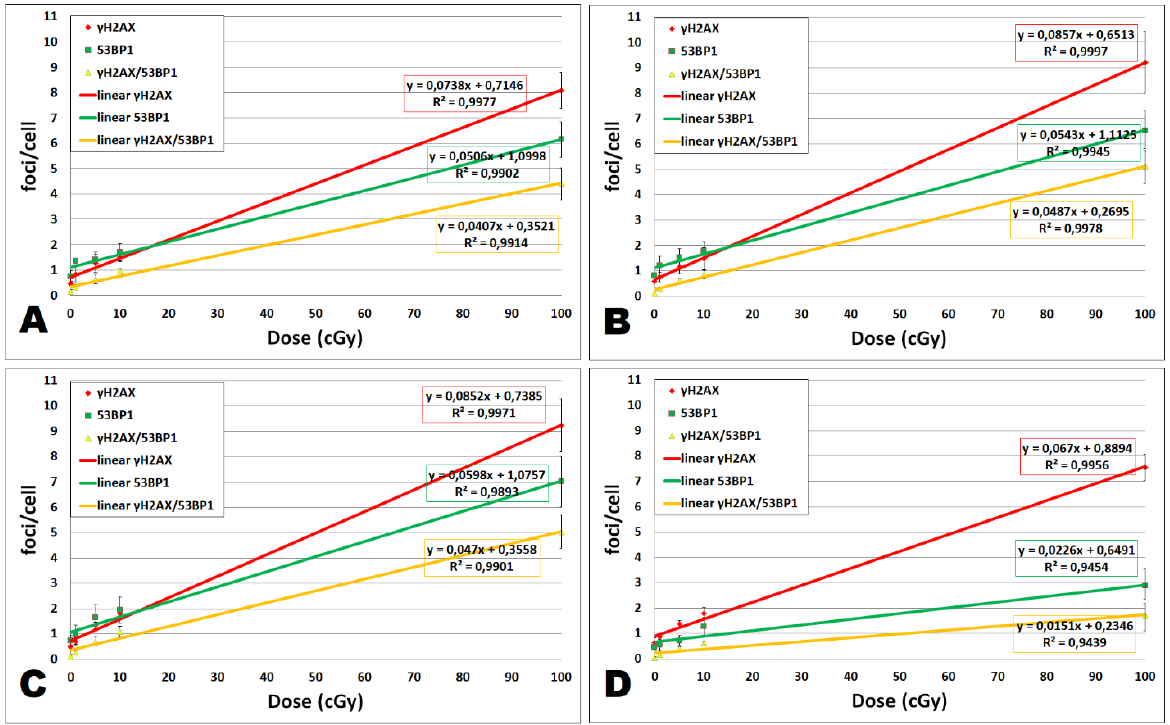
Figure 1. Linear fit for dose dependence of γ H2AX, 53BP1, and colocalized γ H2AX/53BP1 foci at 2 h post-irradiation. Dose dependence of focus induction and linear regression along with the coefficient of determination R 2 is shown for different treatments: ( A ) untreated, ( B ) 0.1% DMSO, ( C ) cal A (1 nM), and ( D ) cal A (10 nM) treatment. Data from 3 experiments are shown for each dose (0, 1, 5, 10, and 100 cGy). Vertical bars represent standard